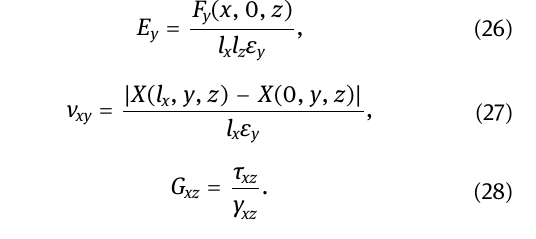
Table 4: Elastic properties of sub - interphase